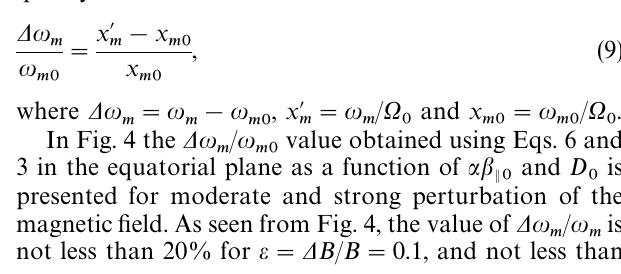
Fig. 3. ‚ eft panel : frequency of the max- imum equatorial growth rate against (cid:97)(cid:98) (cid:69) for D " 1.1 and D " 2 obtained from an accurate formula (Eq. 6) ( solid line ) and from its linear approximation (Eq. 7) ( dashed ); right panel : maximum intensity frequency x (cid:109) as a function of D and (cid:97)(cid:98) (cid:69) in the equatorial plane